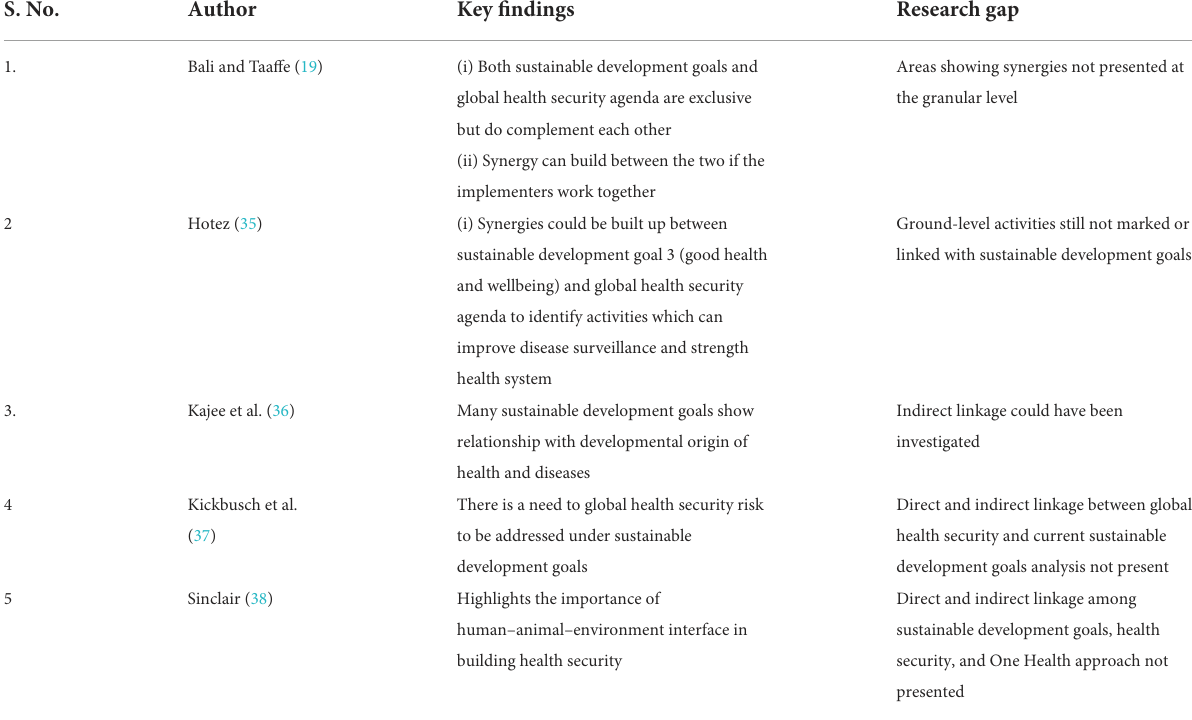
TABLE 1 Important publications and identified research gaps, sustainable development goals, one health, India, 2019–2021. S.